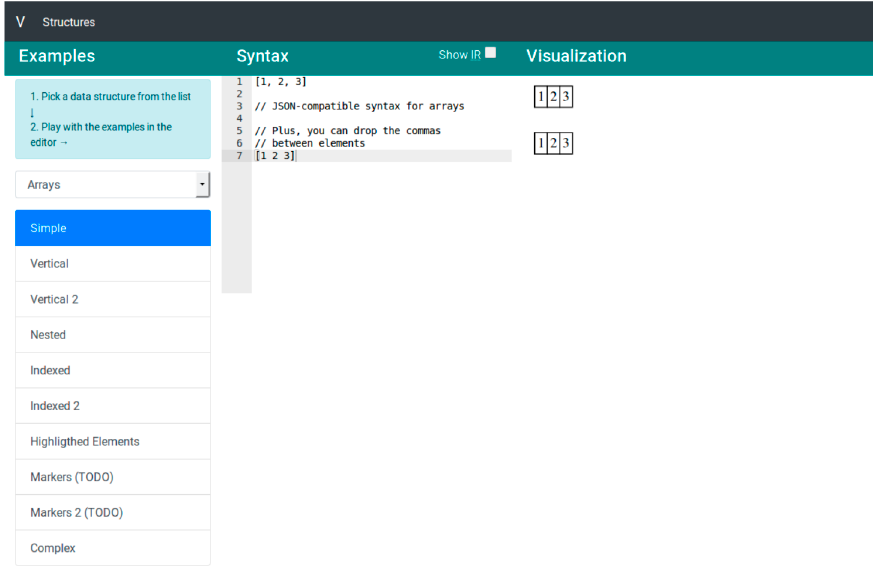
Figure 2. Initial screen of the